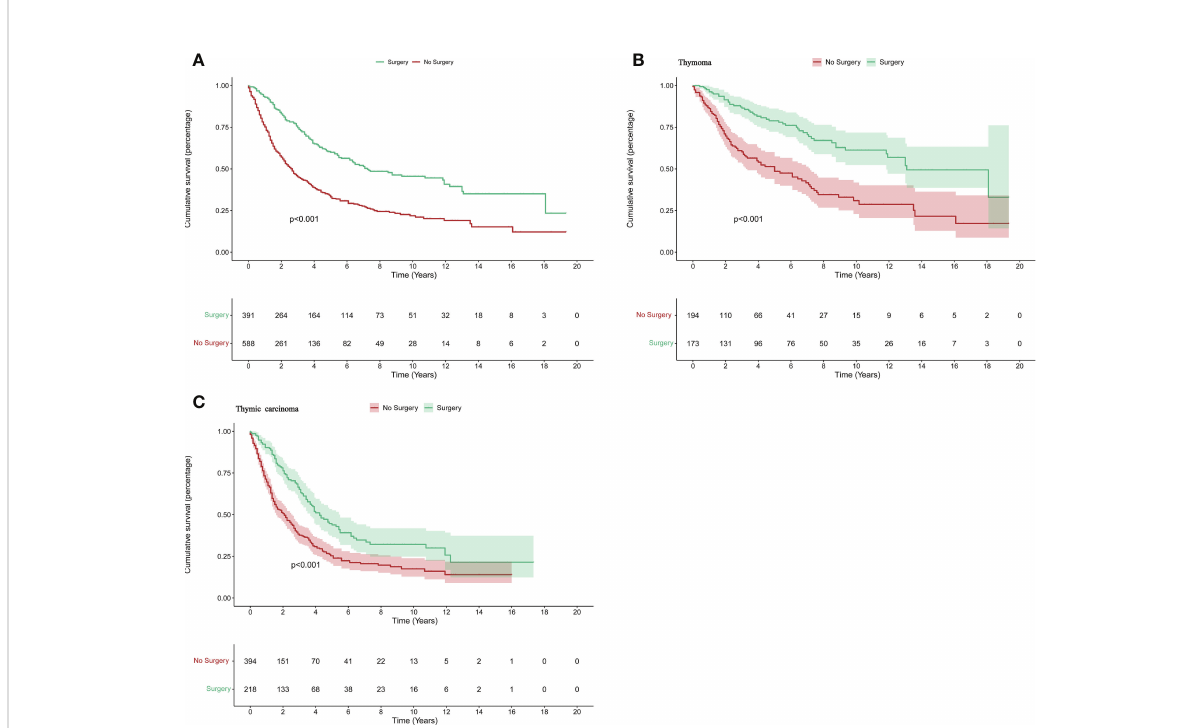
FIGURE 1 The survival difference in patients with thymic tumors. The K – M curve for all patients (A) , patients with advanced thymoma (B) , and advanced thymic carcinoma (C)